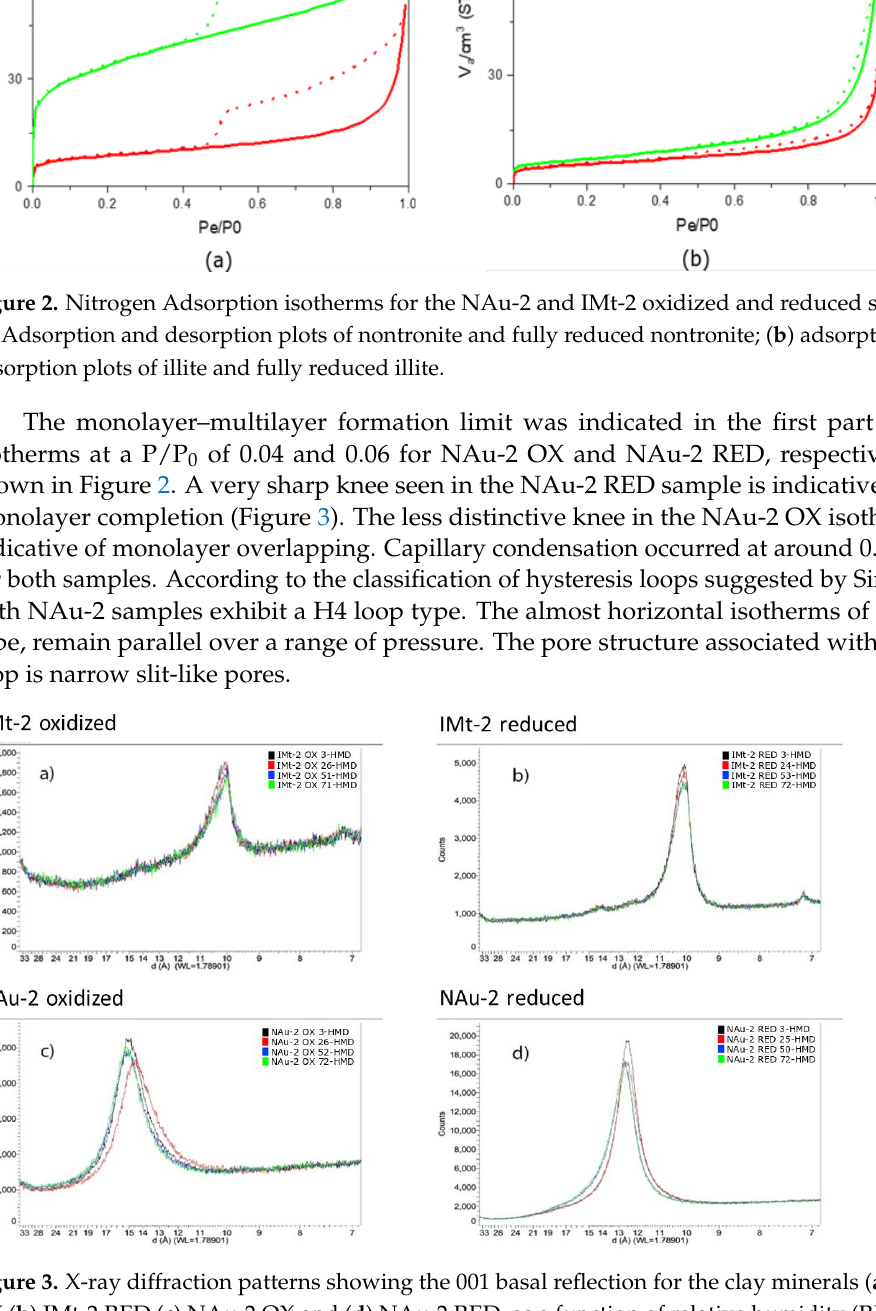
OX ( b ) IMt-2 RED ( c ) NAu-2 OX and ( d ) NAu-2 RED, as a function of relative humidity (RH) with